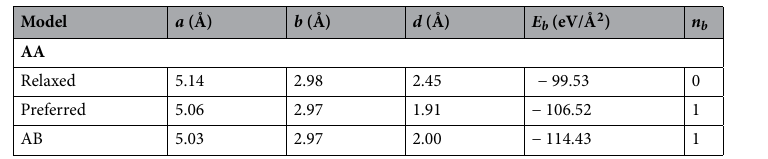
Table 2. Comparison between different models in the freestanding form: lattice constants ( a and b ), interlayer distance ( d ), binding energy ( E b ) and number of interlayer bonds in a unit cell ( n b ).